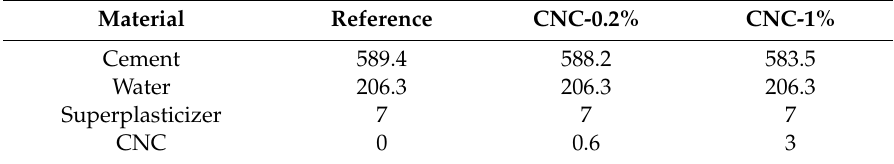
Table 4. Mixture design for the reference sample and samples containing CNCs (kg / m 3